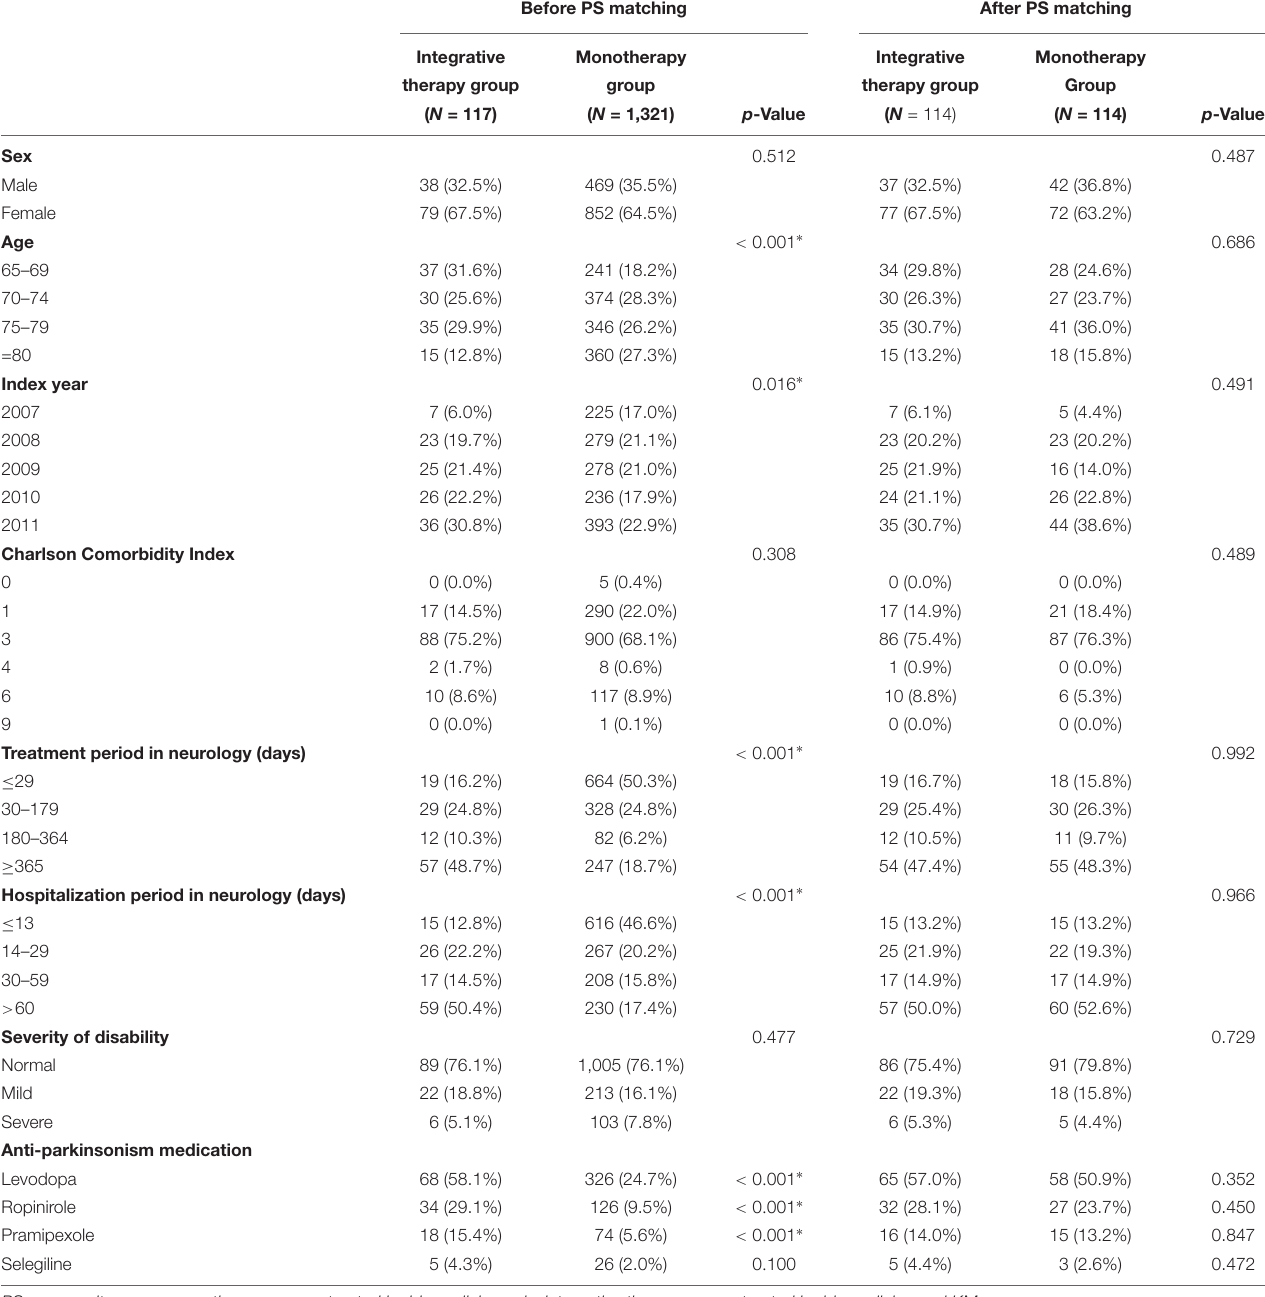
TABLE 1 | Comparison of characteristics between integrative therapy group and monotherapy